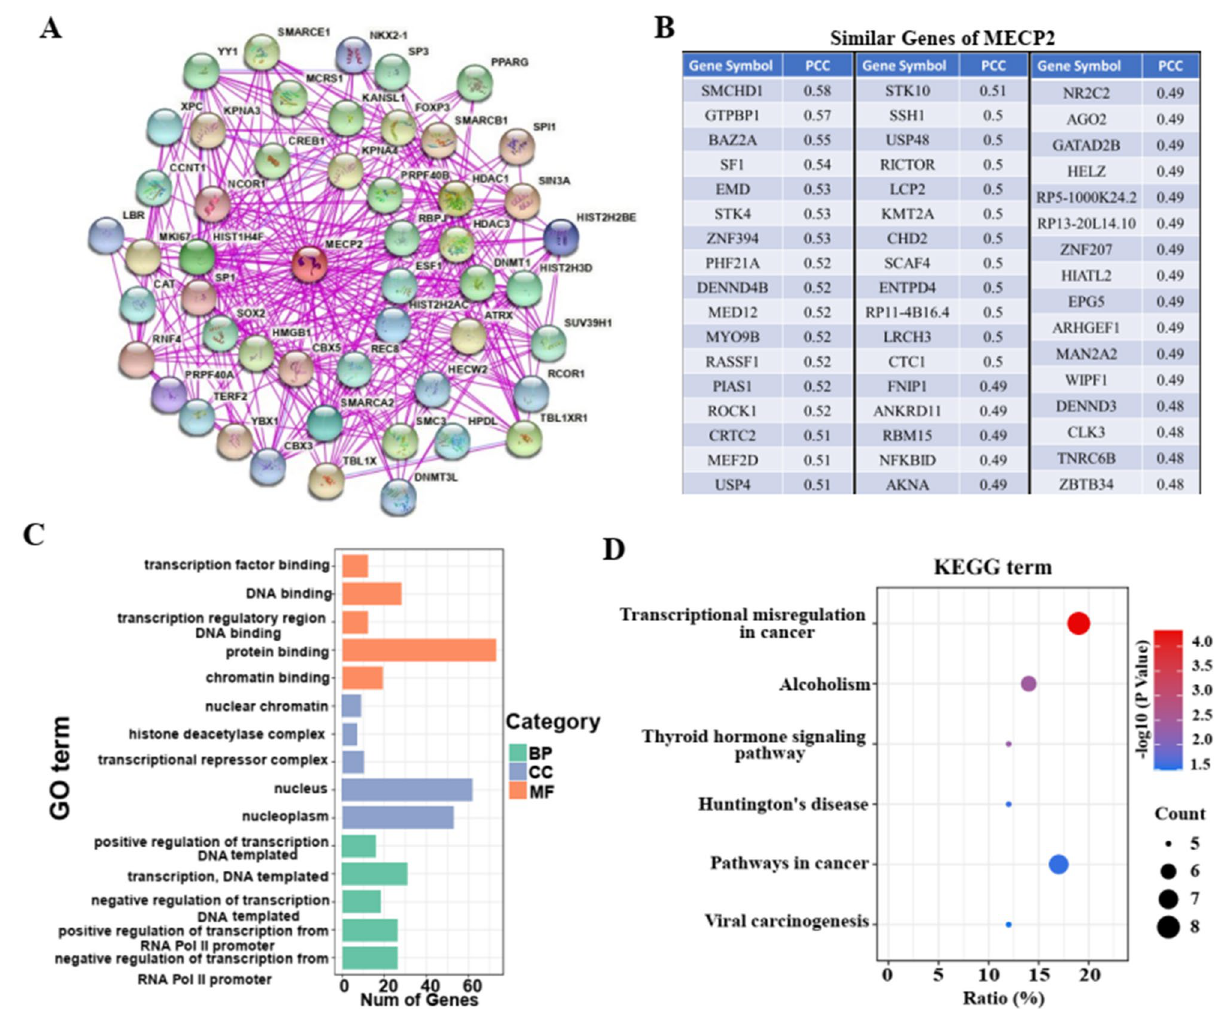
Figure 7. Enrichment analysis of MeCP2-related genes. (A) PPI network analysis of MeCP-binding proteins based on STRING database. (B) The top 50 similar genes of MeCP2 using the GEPIA2 online tool. (C) GO enrichment analysis of MeCP2-related genes. (D) KEGG pathway enrichment analysis of MeCP2-related genes. PPI protein–protein interaction, PCC Pearson correlation coefficient, GO Gene Ontology, BP biological process, CC cell component, MF molecular function, KEGG Kyoto Encyclopedia of Genes and